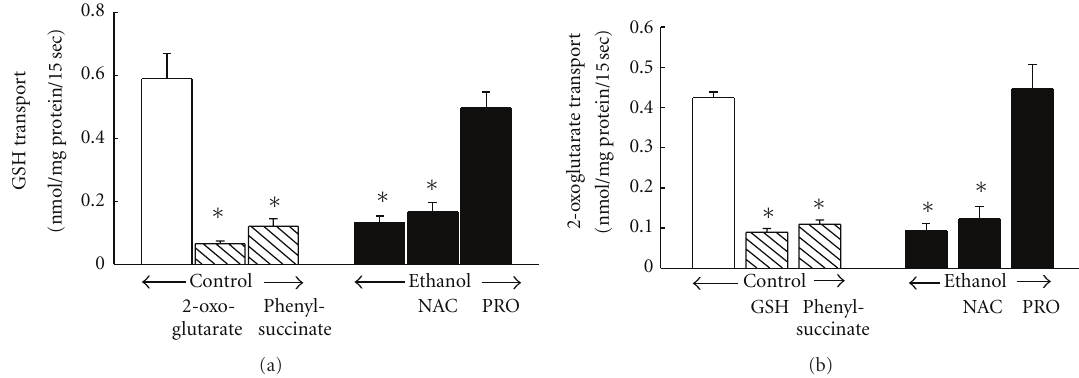
Figure 4: Ethanol impaired mitochondrial GSH (a) and 2-oxoglutarate (b) uptake. The investigation of mitochondrial uptake of GSH and 2-oxoglutarate revealed that procysteine (PRO) but not N-acetylcysteine (NAC) protected the 2-oxoglutarate transporter during ethanol ingestion. The uptakes of 3 H-GSH and 14 C-oxoglutarate were assessed in mitochondria isolated from alveolar type II cells from rats fed control, ethanol, ethanol + NAC, or ethanol + PRO diets. ( ∗ P ≤ 0 . 05) compared to